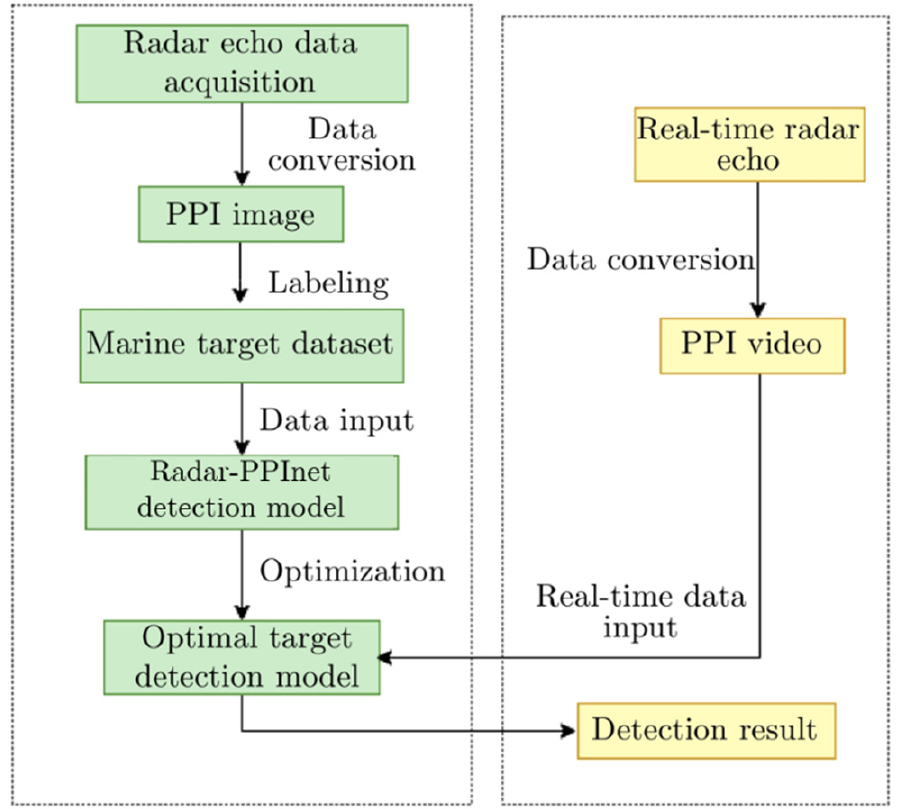
Figure 8. The flowchart of the radar image marine target detection via Radar-PPInet.